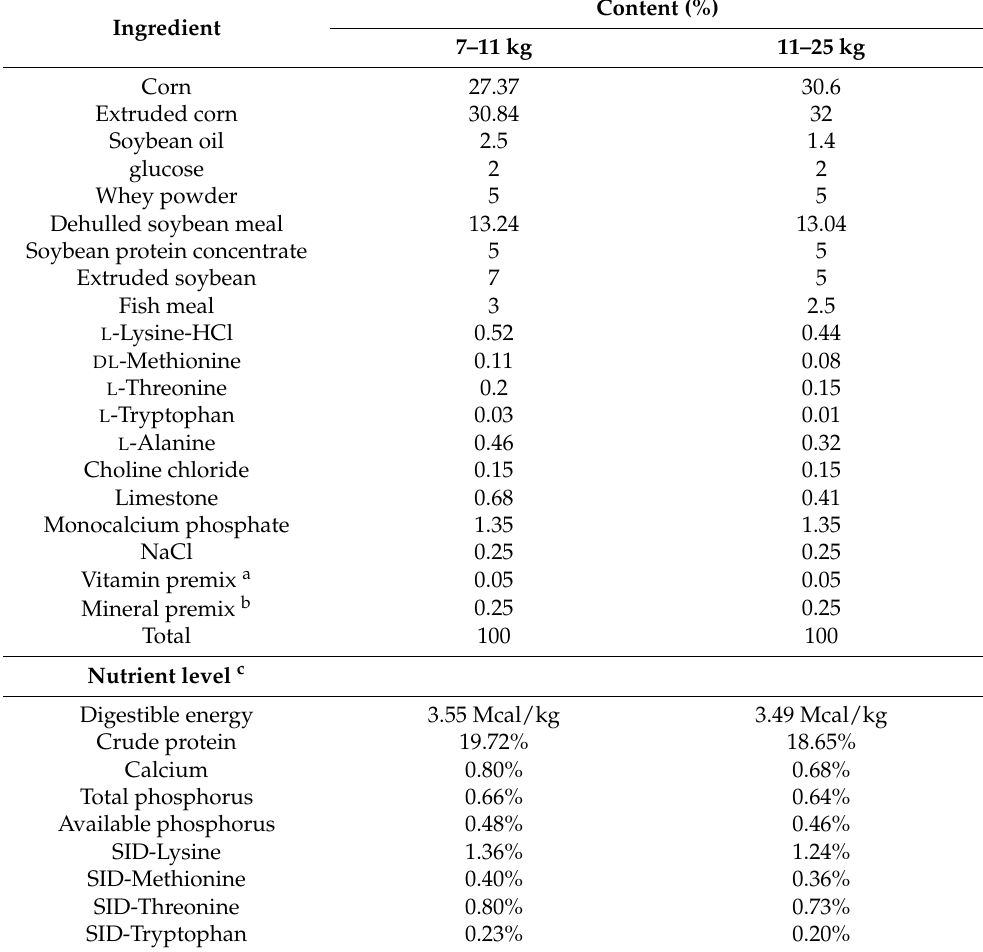
Table 1. Ingredient composition of experimental diets (as-fed